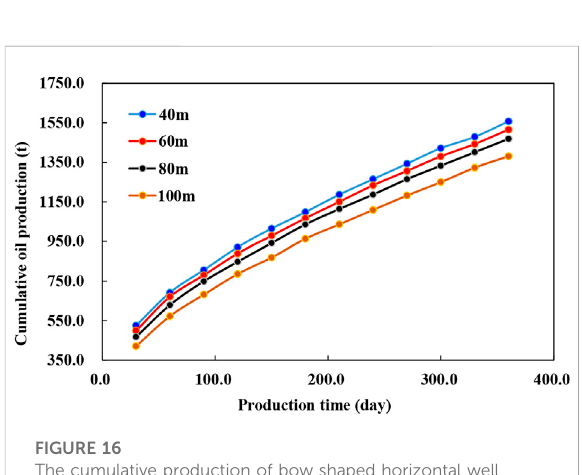
FIGURE 16 The cumulative production of bow shaped horizontal well with half lengths of horizontal